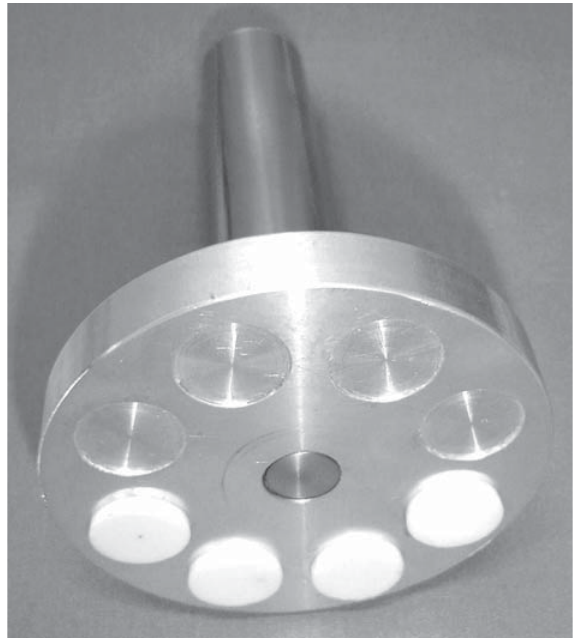
Figure 1- Specimens mounted in the specimen holder